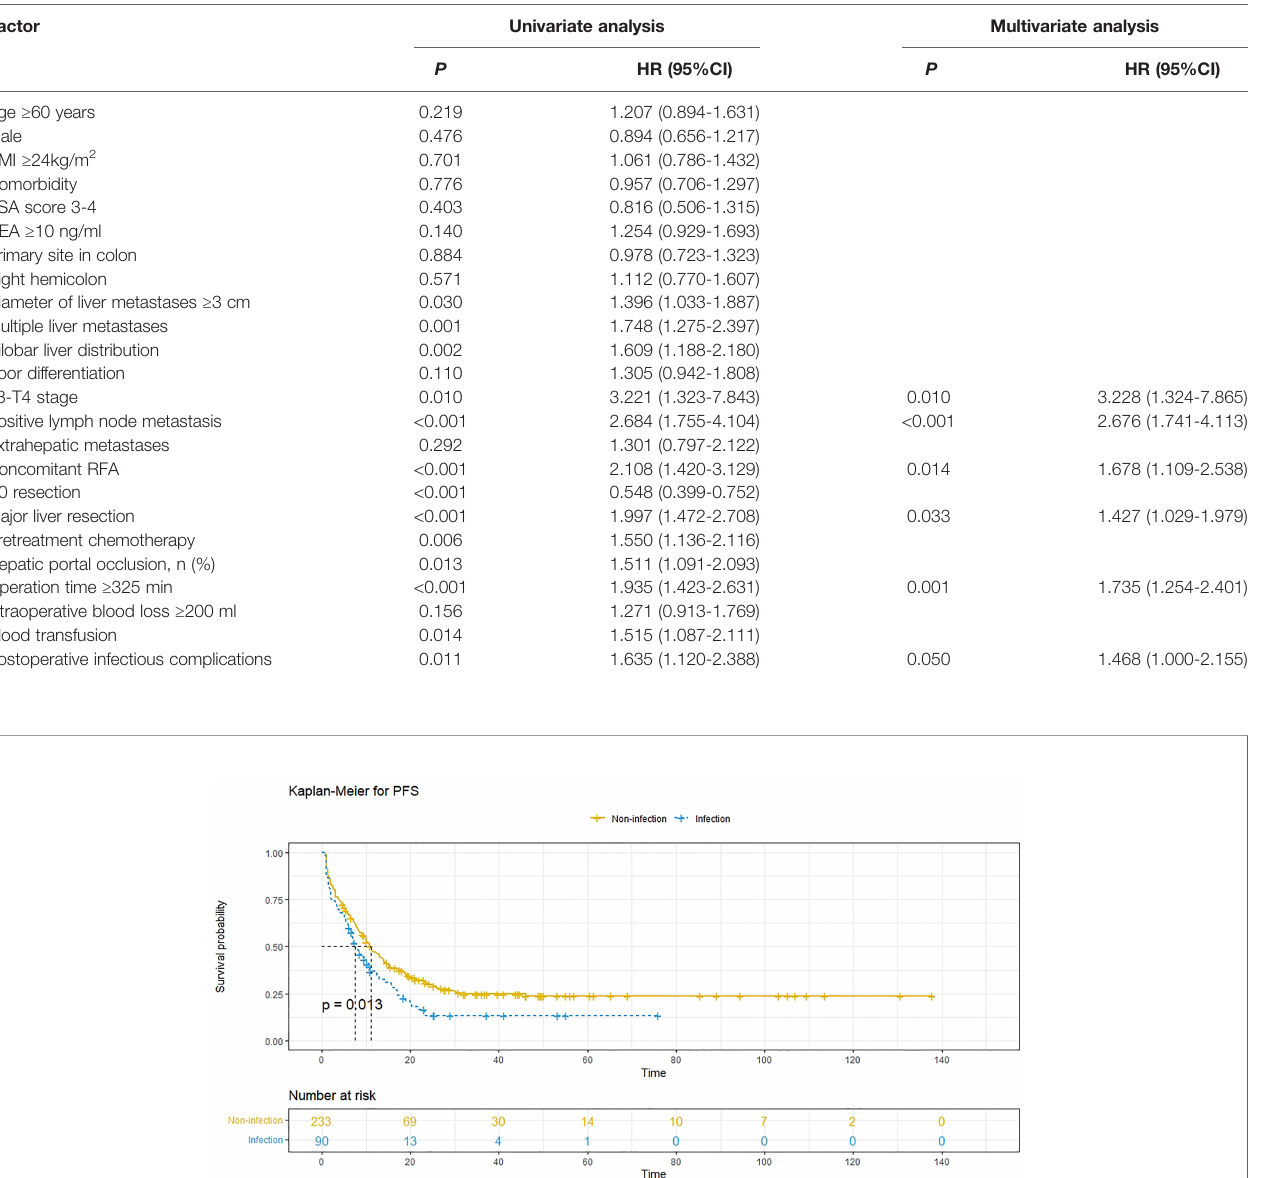
TABLE 5 | Prognostic factors for OS in CRLM patients before PSM. Factor